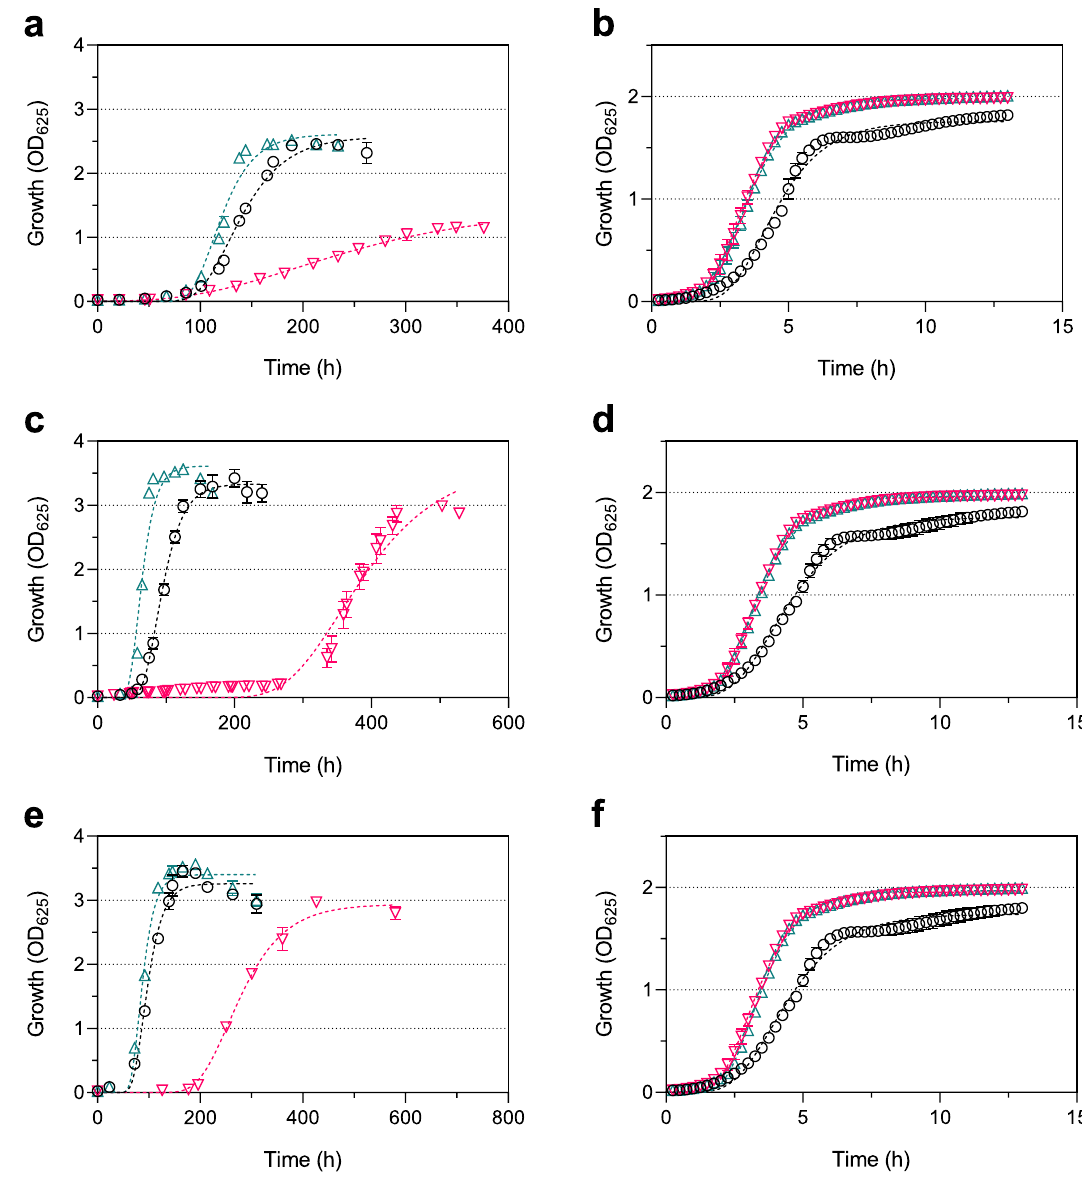
Figure 5. Growth kinetics. Listeria monocytogenes strains DSM 20600 T ( a , b ), FFH ( c , d ) and FFL 1 ( e , f ) grown at 6 °C ( a , c , e ) and 37 °C ( b , d , f ) in tryptic soy broth-yeast extract medium without supplementation (black circles), with 0.1% (wt/vol) of polysorbate 60 (red inverted triangles), and with 0.1% (wt/vol) of polysorbate 80 (green triangles) Values are means ± standard deviation ( n = 3 at 6 °C; n = 8 at 37 only the intercalation of this lipid in the bacterial membrane 34 . This discrepancy may be attributed to the use of ester-bound fatty acids (P60, P80, food extracts) in our study, in contrast to free fatty acids as a supplement in previous studies. We did not study the polar lipids in more detail, as the polar head groups of the membrane lipids have only minor effects on the thermal membrane properties and show no changes in their composition in L . monocytogenes at low growth temperatures 35–37 . Fatty acids with a high T m (saturated, straight-chain fatty acids) decrease membrane fluidity, whereas fatty acids with a low T m (unsaturated and branched-chain fatty acids) increase membrane fluidity 38 . TMA-DPH- dependent anisotropy measurements confirmed the influence of exogenous fatty acids on the membrane fluid- ity of whole living cells with a complex lipid composition (Fig. 2). None of the strains showed the two typical plateaus that indicate the two temperature-dependent ultimate states of biomembranes: the gel-like solid-state (high TMA-DPH anisotropy) and the liquid-crystalline liquid-state (low TMA-DPH anisotropy). A linear curve progression rather than a sigmoidal curve described the relation between anisotropy and measuring temperature for all strains tested, which generally describes the phase transition of the membrane 39 . The cultures grown in TSB-YE supplemented with P80 or SSE showed a higher membrane fluidity in all strains than those without supplementation. These results indicated significantly more fluid membrane below 20 °C and unchanged fluidity